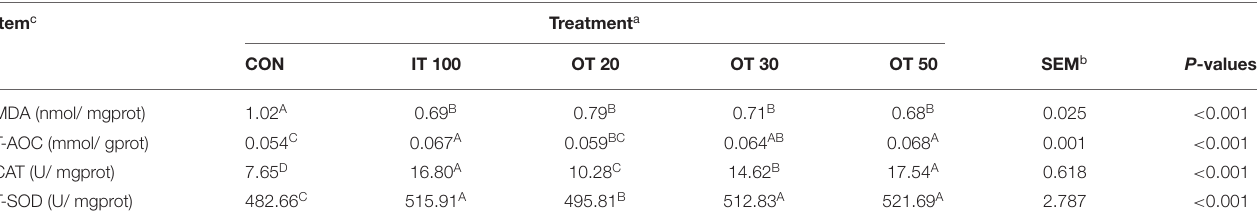
TABLE 5 | Effects of inorganic and reduced substitution of organic trace minerals on antioxidant status of eggshell gland at the 8th week of the experiment with hen layer at the age of 67 weeks. Item c